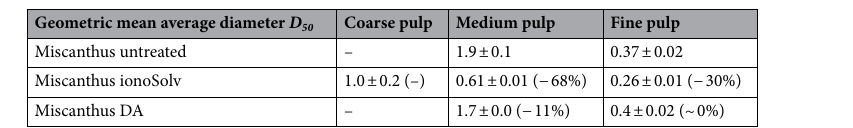
Table 3. D 50 values (in mm) obtained for untreated biomass and recovered pulps after IL and DA pretreatments. Particle size distributions were obtained by sieving. Values in brackets denote the percentage change in D 50 values of the treated pulp based on the original untreated